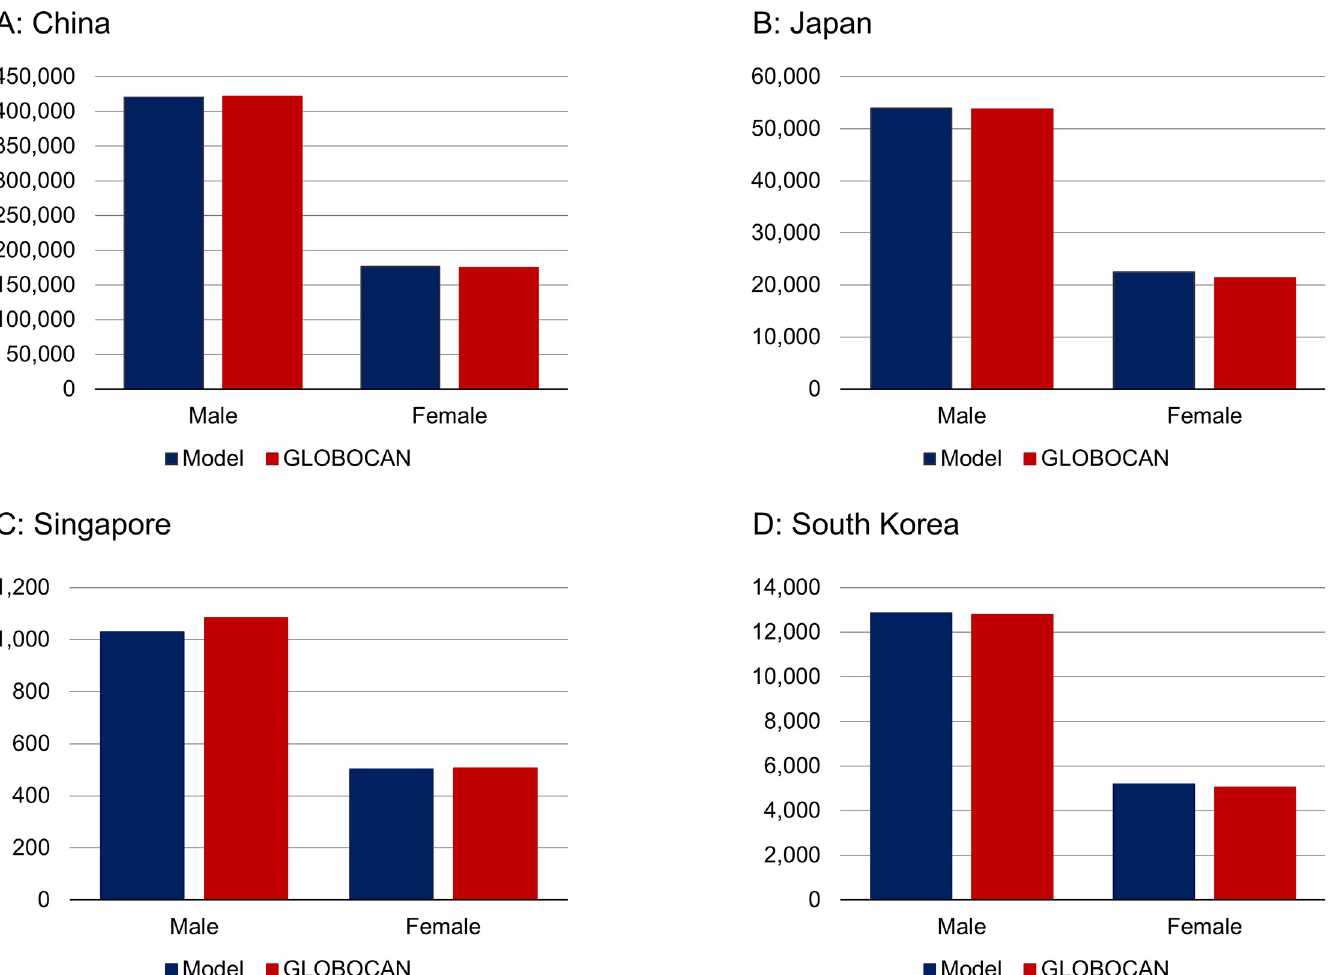
Fig 2. Lung cancer mortality calibration. Model lung cancer mortality calibrated to data from GLOBOCAN. GLOBOCAN: Datasets about the global burden of cancer released by the International Agency for Research on Cancer (IARC). (A) China. (B) Japan. (C) Singapore. (D) South Korea.